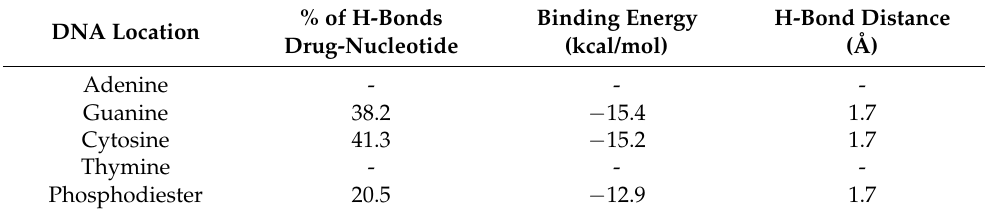
Figure 12. 3-D structure of ELT bound to 1BNA via intercalation mechanism at pH 7.4. Along with the MD results, the cluster analyses of 1000 poses having high docking scores taken from the docking simulations were evaluated. The results showed that the drug forms strong H-bonds at a distance of 1.7 Å, and 80% of the H-bonds were with guanine (G) and cytosine (C) nucleotides of 1BNA and the obtained free energy of binding (docking score) was − 15 kcal/mol. The drug unzips and bends the double helical structure of 1BNA. Intercalation mainly occurs via minor grooves of DNA. However, in some minor clusters, the drug also chooses to intercalate via the adjacent phosphodiester sugar backbone of guanine and cytosine, with a relatively lower docking energy of − 12.9 kcal/mol (Table 4). Table 4. Eltrombopag post-molecular dynamics hydrogen bond contact analyses.